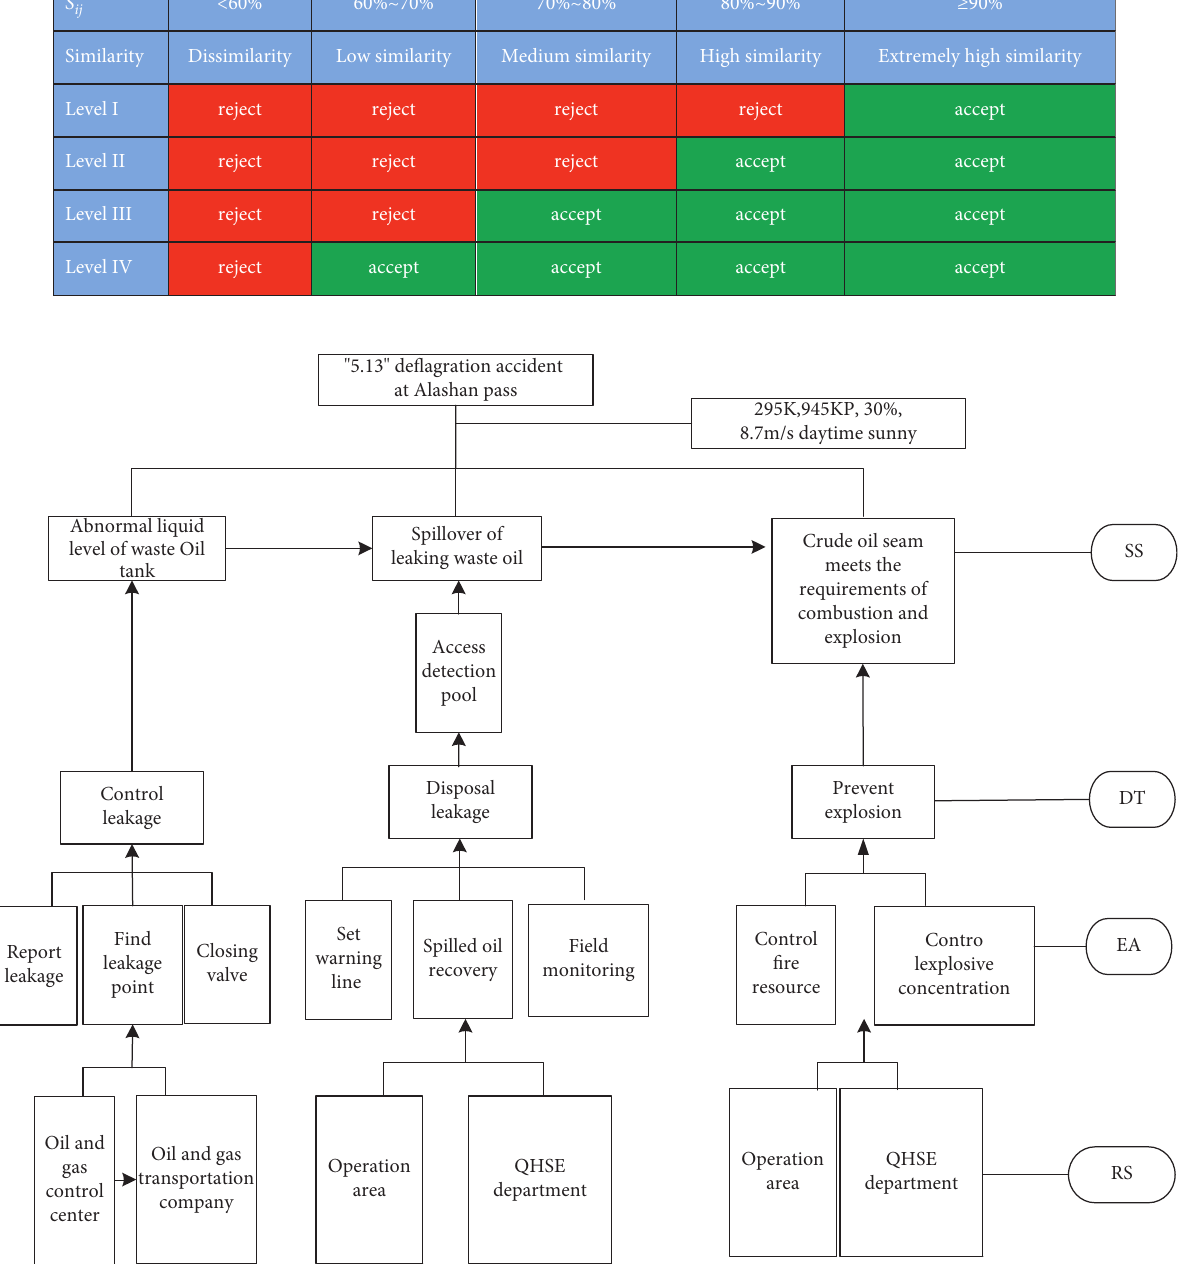
Figure 3: Scenarios of the “5.13” deflagration accident at Alashan